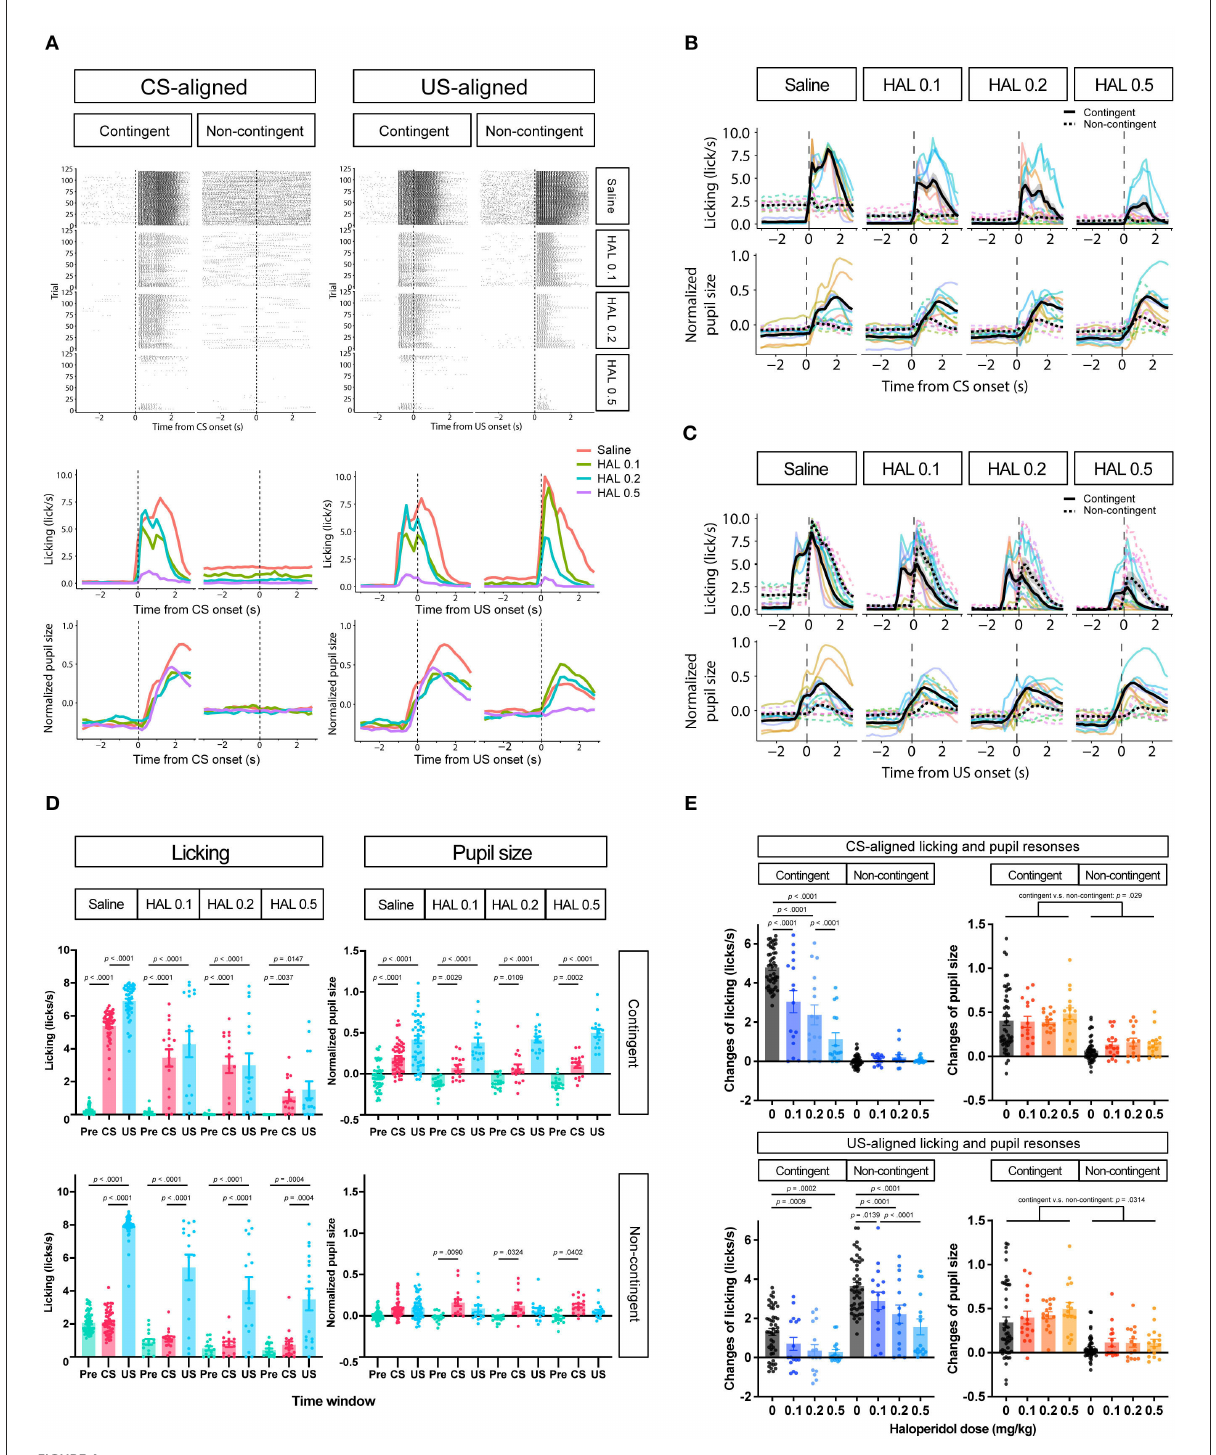
FIGURE4 Effects of haloperidol injection on the licking and pupil responses after Pavlovian conditioning training. (A) Representative raster plot (top), temporal change in licking, and pupil responses (middle and low) of individuals in contingent and non-contingent groups. Periods of 1s